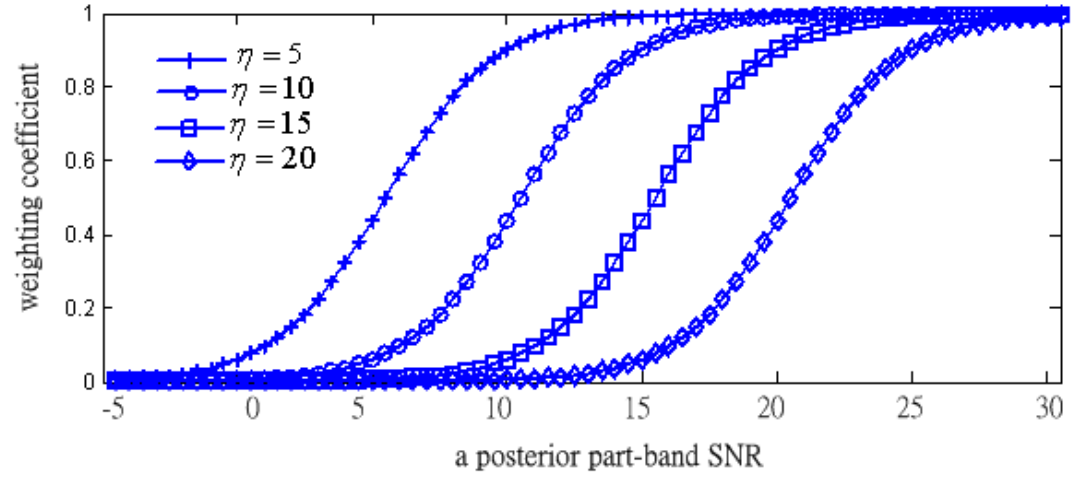
Figure 7. The plots of weight coefficients against a posterior part-band SNR under variable 